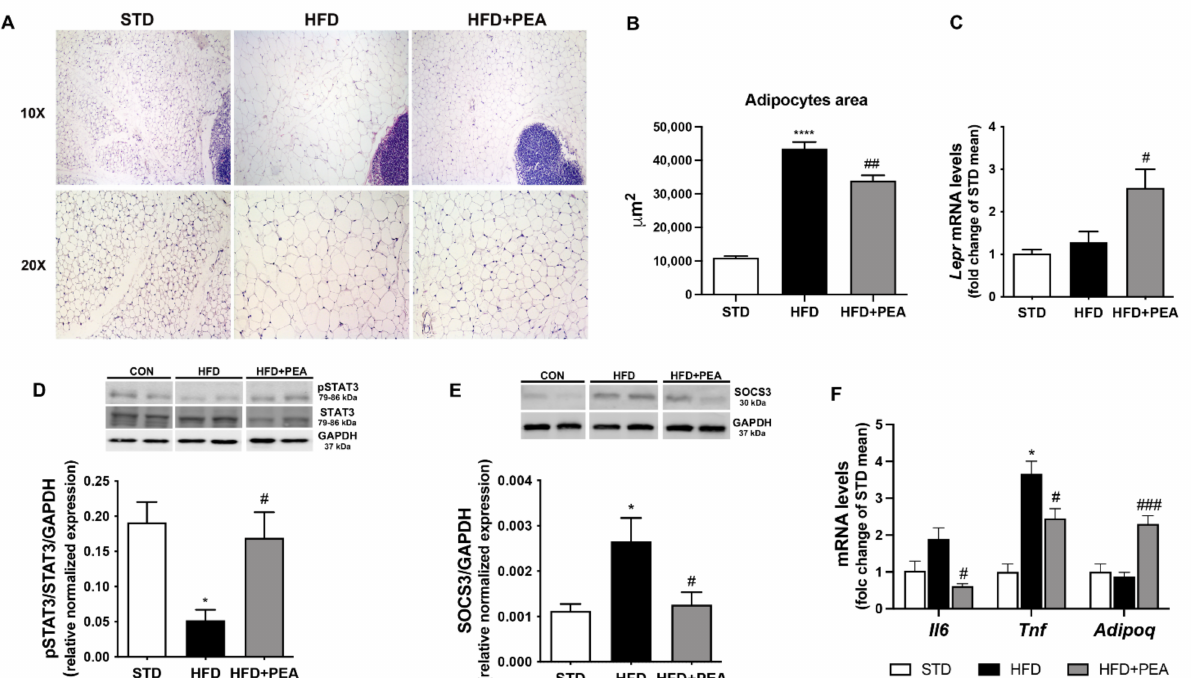
Figure 2. PEA promotes adipose tissue remodeling, restores leptin signaling and reduces inflam- mation in HFD animals. ( A ) Representative H & E of the paraffine-embedded alternate section of scWAT for all experimental groups (n = 7 animals for each group). ( B ) The mean of adipocyte size in scWAT is also shown. ( C ) Real-time PCR of leptin receptor ( LepR ) and protein expression of ( D ) phospho-STAT3 and ( E ) SOCS3 are evaluated in scWAT (n = 5–7 each group). ( F ) The mRNA transcription of Il6 , Tnf , and AdipoQ in scWAT are measured (n = 5–6 each group). Results are shown as mean ± SEM. * p < 0.05, **** p < 0.0001 significantly different from STD; # p < 0.05, ## p < 0.01, ### p < 0.001 from